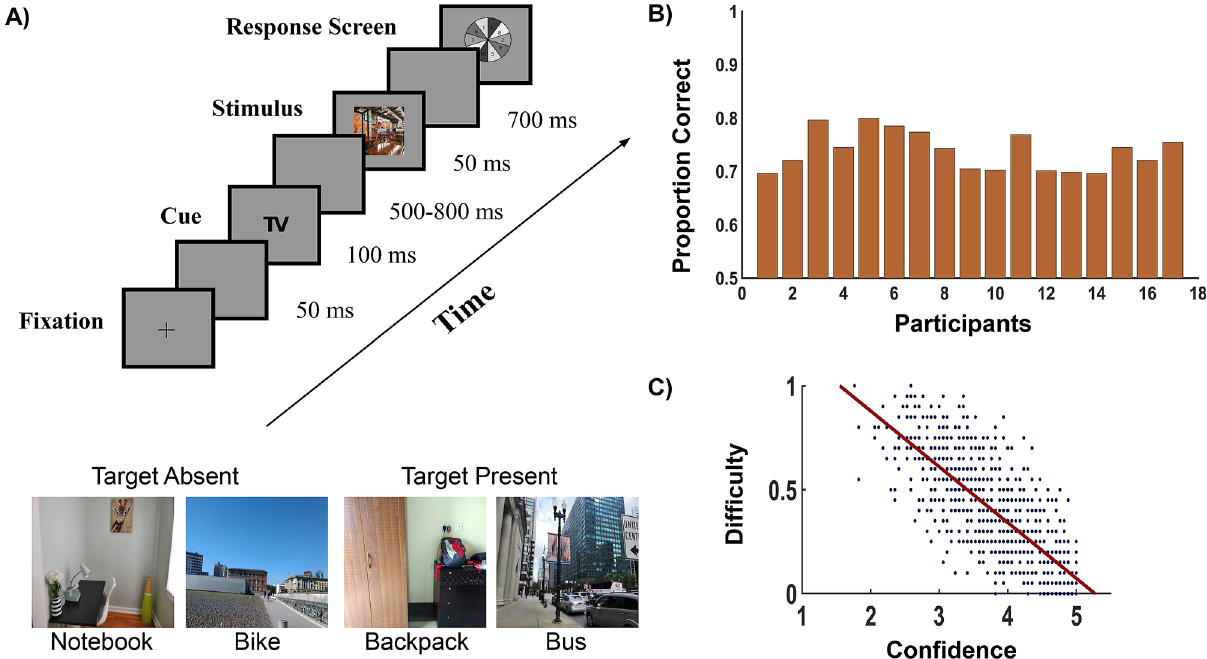
Figure 1. Experimental Protocol and Participant Behaviour. ( A ) Experimental Paradigm and example of Target Present and Target Absent natural scene images. ( B ) Behavioural performance of the seventeen participants. ( C ) Correlation between difficulty of the trials and mean individual confidence of the participants. Individual confidence decreases with task